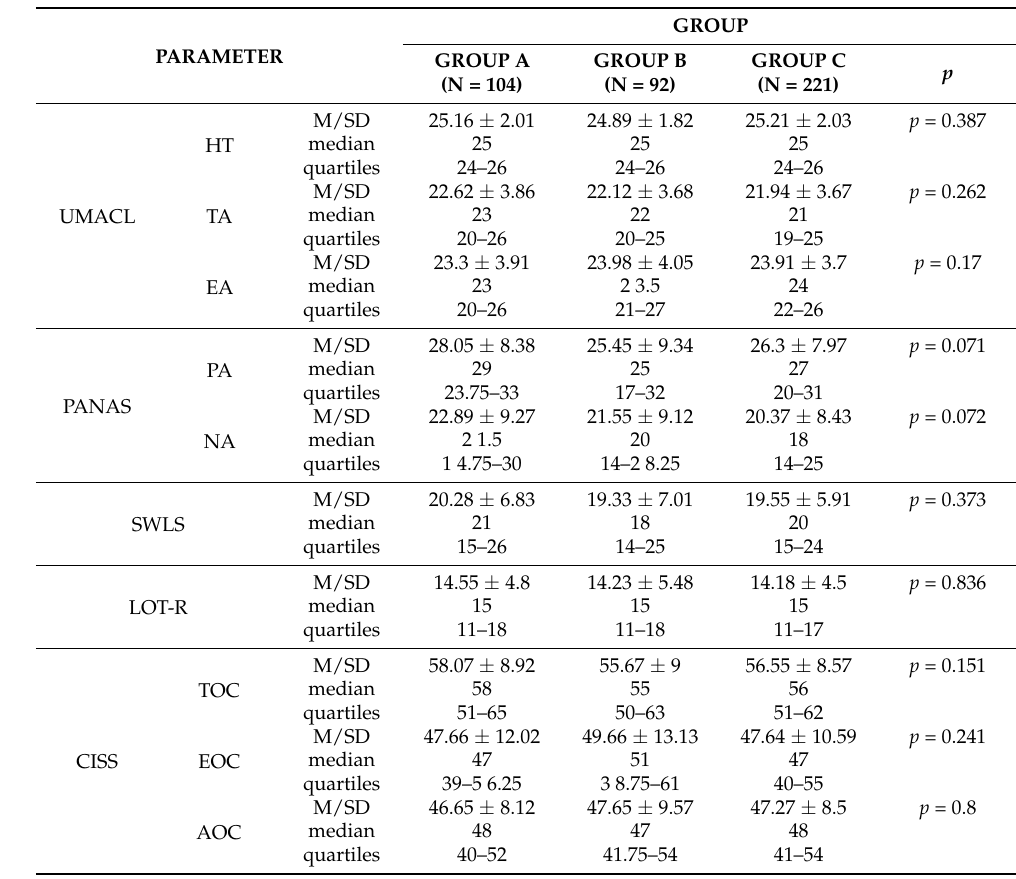
Table 4. Differences between groups on psychological